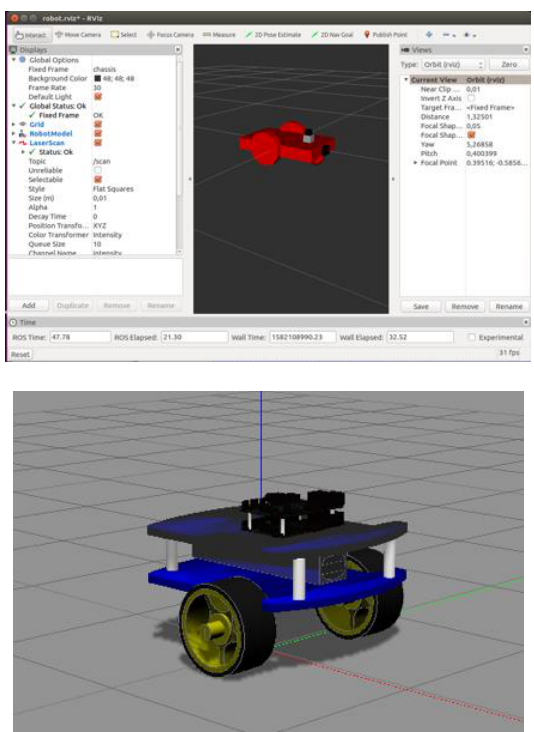
Fig. 7. Models of mobile robots in the rviz